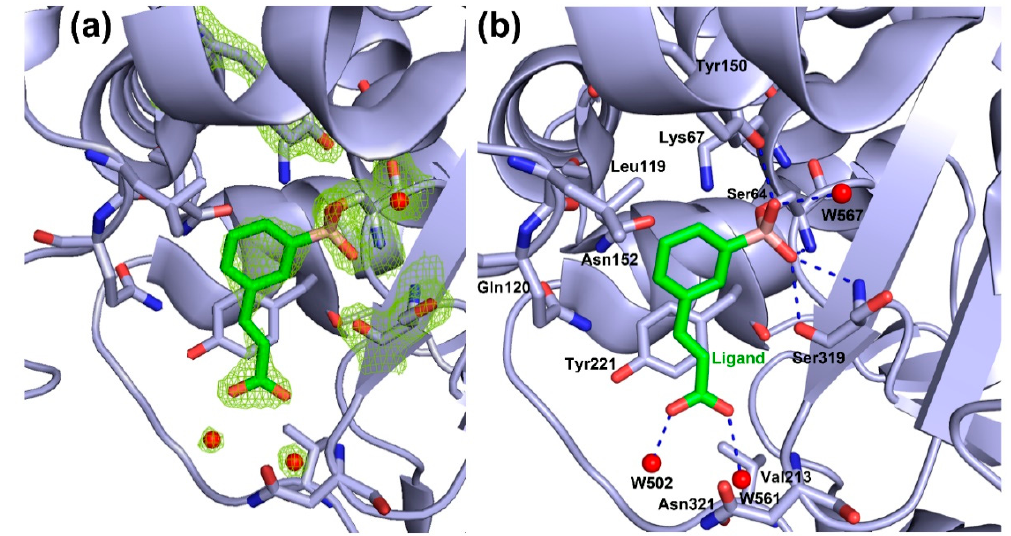
Figure 5. Binary complex of Pa AmpC: 3 . ( a ) The 2 F o- F c electron density map of the active-site residues contoured at 2.0 σ level is shown in green mesh. ( b ) Residues around the binding pocket of the Pa AmpC: 3 crystal structure involved in the main interactions with the inhibitor molecule are shown as sticks (carbon atoms in green for the ligand and in light blue for Pa AmpC, oxygen atoms are in red, nitrogen atoms in blue and the boron atom in pink). Polar interactions within 3 Å are shown in blue dashed lines. Water molecules interacting with the ligand molecule are depicted as a red sphere. Pictures were prepared by using PyMOL [29].